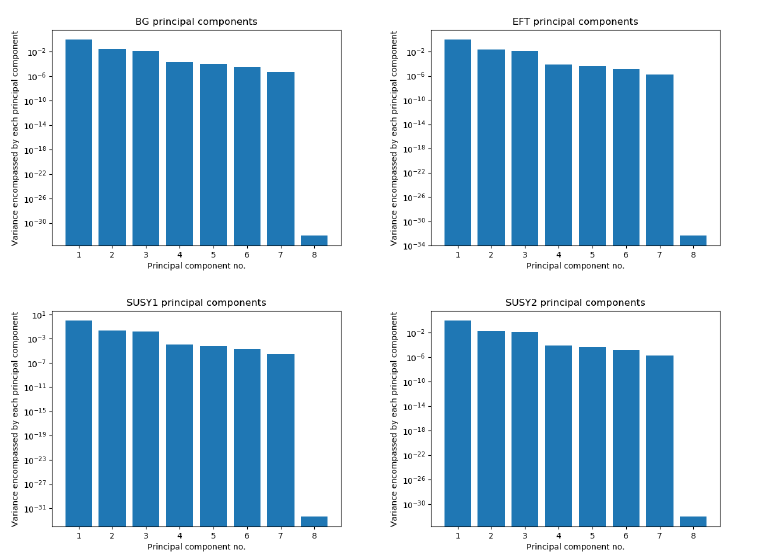
Figure A2: The variance ratio of the new principal component axes (with the number of principal component axes being 8, the same number of original features), high- lighting the relative importance of the principal components in terms of capturing variance in the datasets.